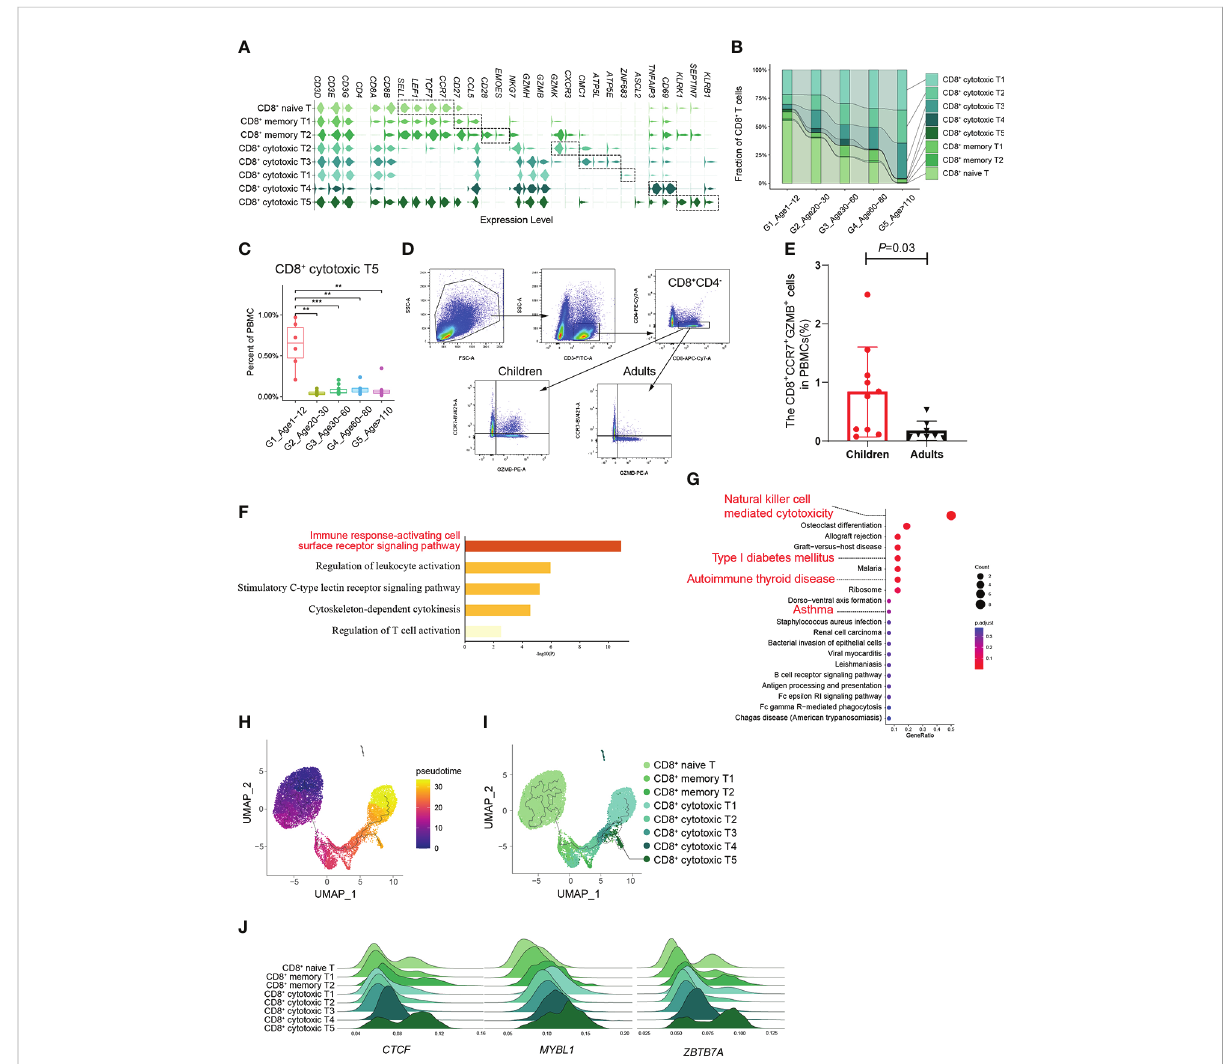
FIGURE 3 A distinct subtype of CD8 + cytotoxic T cells in childhood. (A) Violin plots showing the expression distribution of selected canonical cell markers in the 8 subtypes of CD8 + T cells. (B) Composition of CD8 + T cells in the 5 age groups. (C) Boxplots of the percentage of CD8 + cytotoxic T5 subtype in PBMCs. All differences with P <0.01 are indicated. ** P <0.001; *** P <0.0001. (D) The gating strategy of CD8 + CCR7 + GZMB + T cells analyzed by fl ow cytometry. (E) The scatter plot showed the proportion of CD8 + CCR7 + GZMB + T cells in PBMCs of healthy children and healthy adults (P=0.03). Differences with P <0.05 are indicated. (F, G) Results of GO enrichment analysis (F) and KEGG pathway enrichment analysis (G) of the top50 marker genes of CD8 + cytotoxic T5. (H) Pseudotime trajectory of CD8 + T cells in G1 estimated using Monocle 3. (I) Pseudotime trajectory of CD8 + T cells in each group estimated using Monocle 3. (J) Transcription factors unique to the CD8 + cytotoxic T5